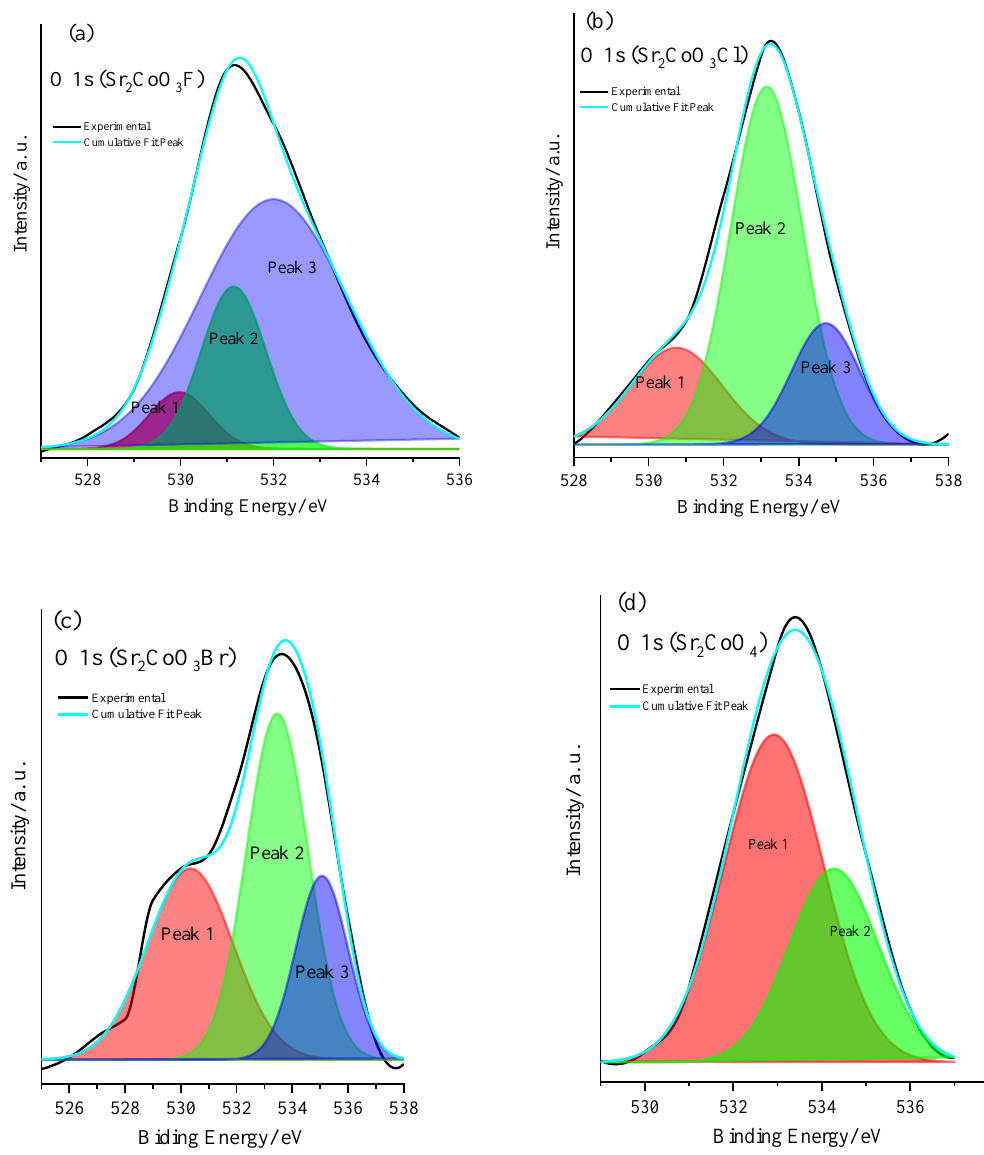
Figure 4. The core-level of O 1s spectra of ( a ) Sr 2 CoO 3 F, ( b ) Sr 2 CoO 3 Cl, ( c ) Sr 2 CoO 3 Br and ( d ) parent Sr 2 CoO 4 catalyst. Table 2. Analysis values of the deconvoluted O 1s peaks of the oxyhalide catalysts. Catalyst